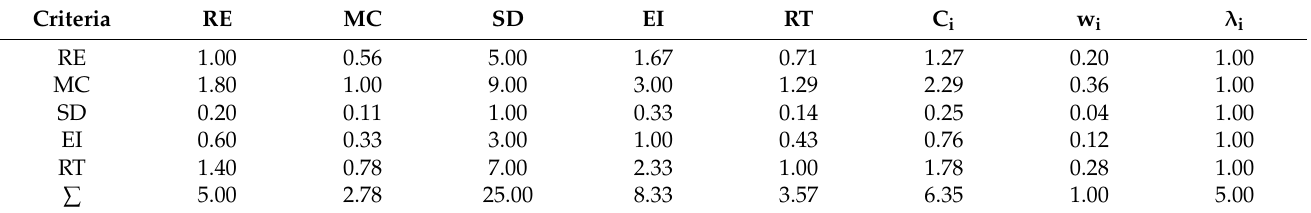
Table 1. Weighting of